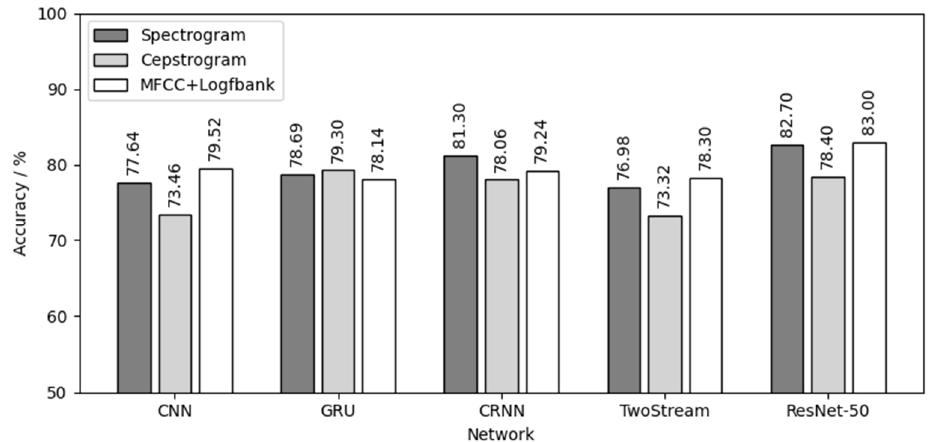
Figure 16. Three yellow chick calls for both training and testing.